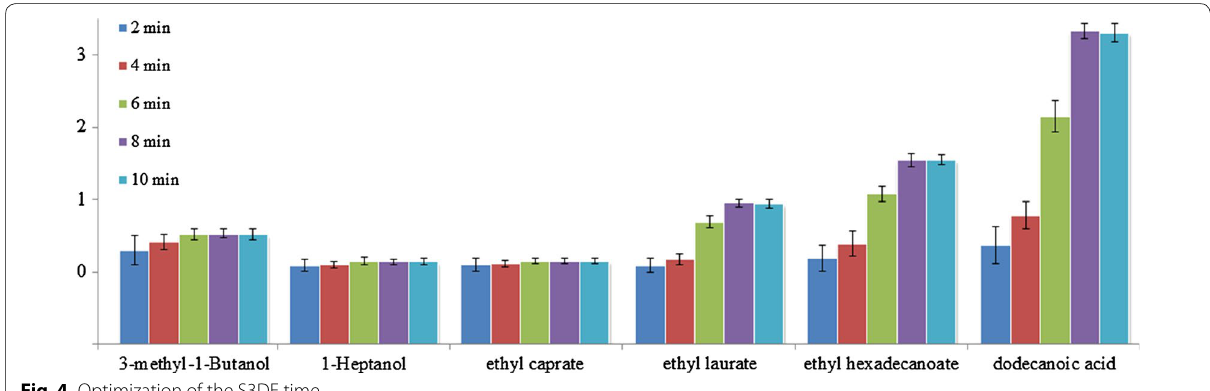
Fig. 4 Optimization of the S3DE